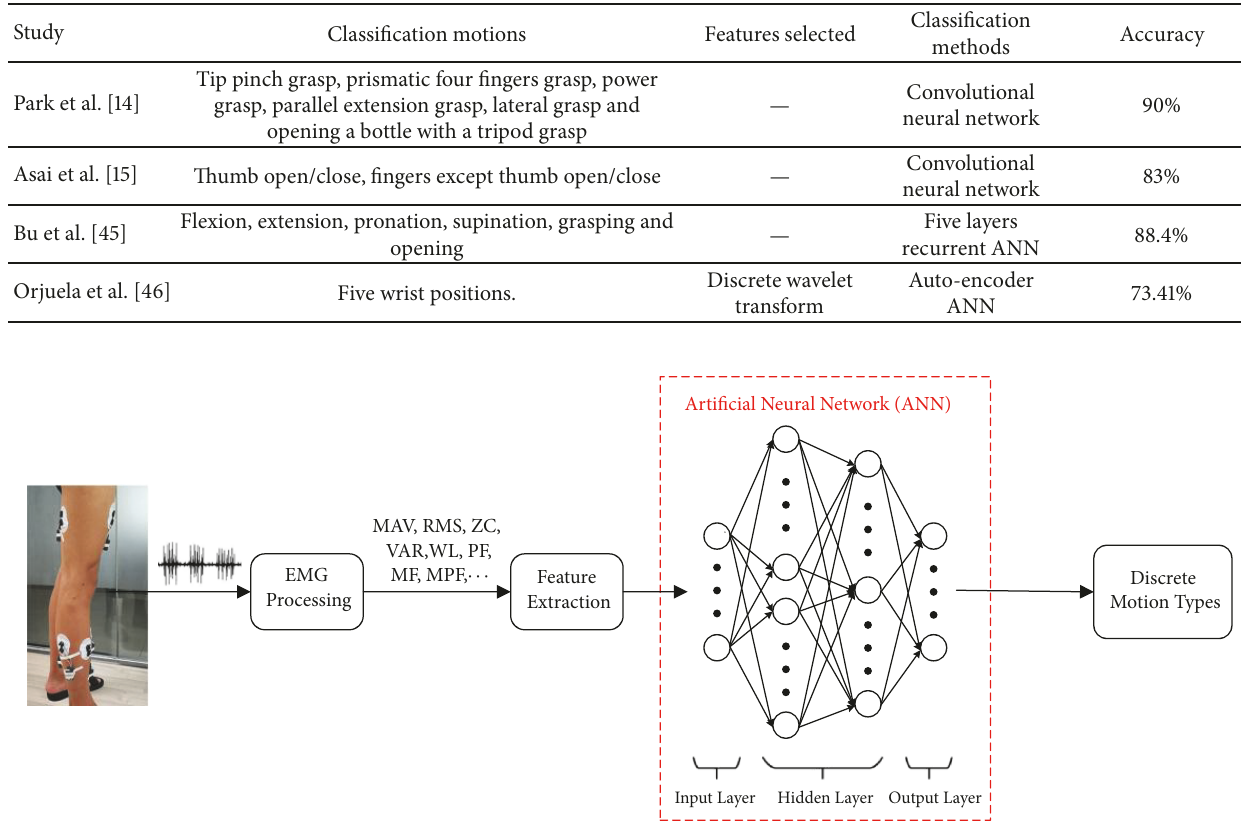
Figure 4: The process of ANN based discrete-motion